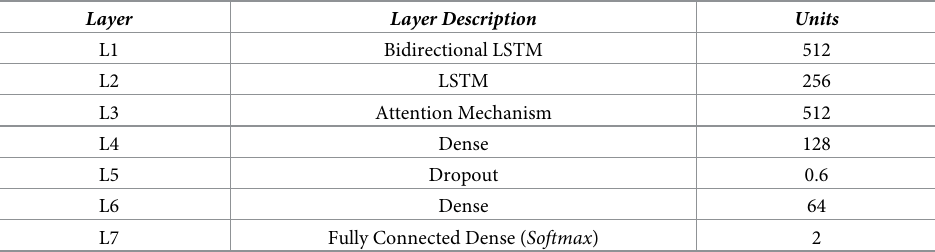
Table 2. Bi-LSTM-A model